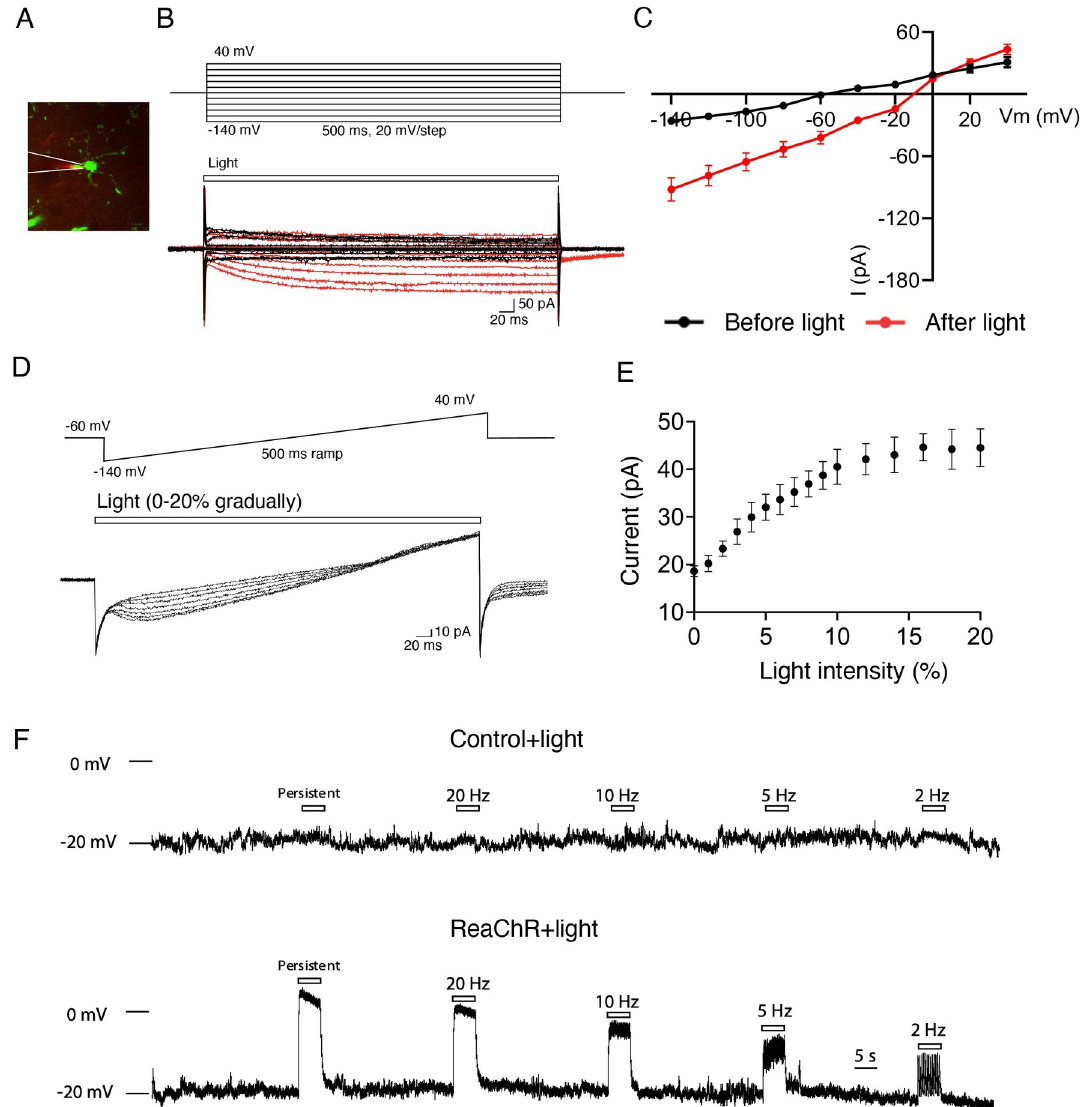
Fig 2. Optogenetic activation of spinal microglia evokes inward currents and membrane depolarization. (A) A representative image of mCitrine + microglia being recorded through whole-cell patch-clamp electrophysiology in spinal cord slices of ReaChR (CX3CR creER/+ : R26 LSL-ReaChR/+ ) mice. (B) Microglia membrane currents from baseline (before red light stimulation, black traces) or ReaChR activation (after red light stimulation [intensity 8% from 54.5 mW], red traces) in ReaChR mice. Microglia were held at − 60 mV, then underwent 500-ms voltage steps from − 140 to +40 mV (20 mV steps). (C) Summarized plot of current (I, [pA]) vs. holding potential (Vm, [mV]) in spinal microglia from ReaChR mice before light (black traces) and after light stimulation (red traces). (D) Voltage ramp tests from − 140 to +40 mV in response to the gradual increase of light intensity (0%–20% from 0.2 to 121.8 mW). (E) A summarized graph depicts that the increase of optogenetic current in microglia correlates with the increase in light intensity. (F) The current clamp recording of microglia shows the changes in membrane potential in response to 5-s light stimulation (intensity 8% from 54.5 mW, pulse duration 45 ms) at indicated frequencies in control (CX3CR creER/+ ) mice (upper) and ReaChR mice (lower). For data plotted in graphs, see S1 Data. ReaChR, red-activated